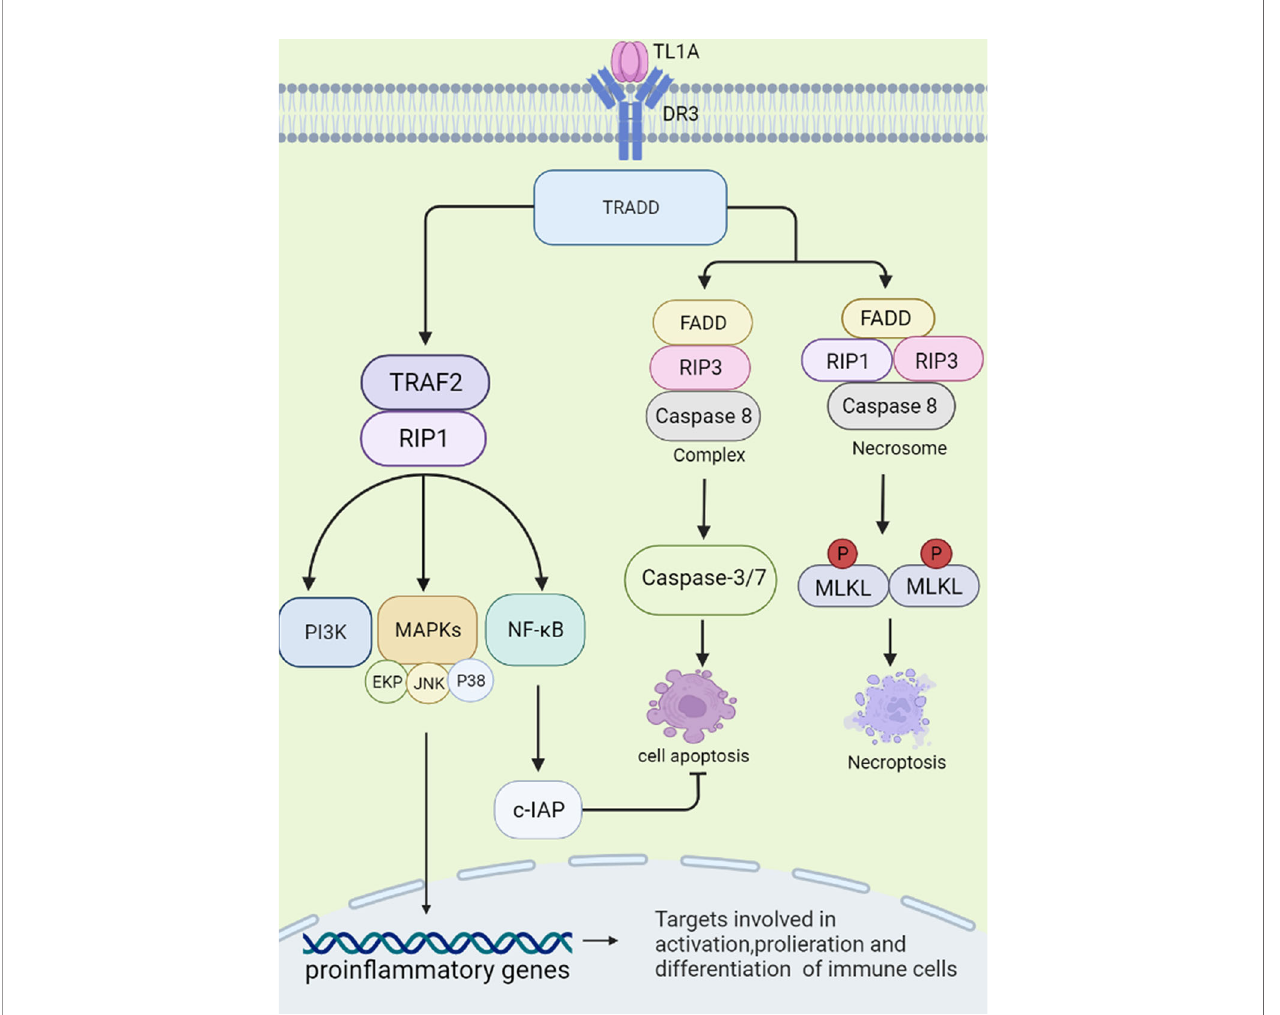
FIGURE 1 | Signal transduction initiated by TL1A/DR3. TL1A binds to the receptor DR3 and activates the TRADD pathway. The complex exerts pro-in fl ammatory effects by regulating downstream pathways, such as TRAF2, RIP1, PI3K, MAPKs, NF- k B, and then regulates cytokine, chemokine secretion. TL1A/DR3 is involved in promoting apoptosis and necroptotic cell death through FADD, RIP3, Caspase-8/-3/-7 pathways. NF- k B can activate c-IAP protein, which can negatively regulate apoptosis. TRADD, TNFR-associated death domain protein; TRAF2, TNFR-associated factor 2; RIP1, receptor-interacting protein 1; PI3K, phosphatidylinositol 3- kinase; MAPKs, mitogen-activated protein kinases; NF- k B, nuclear factor kappa B; FADD, fas-associated death domain; RIP3, receptor-interacting protein 3; c-IAP, cellular inhibitor of apoptosis